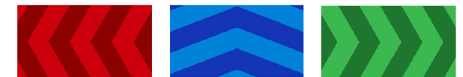
Fig. 4. Colour­coded navigation message with direction indication